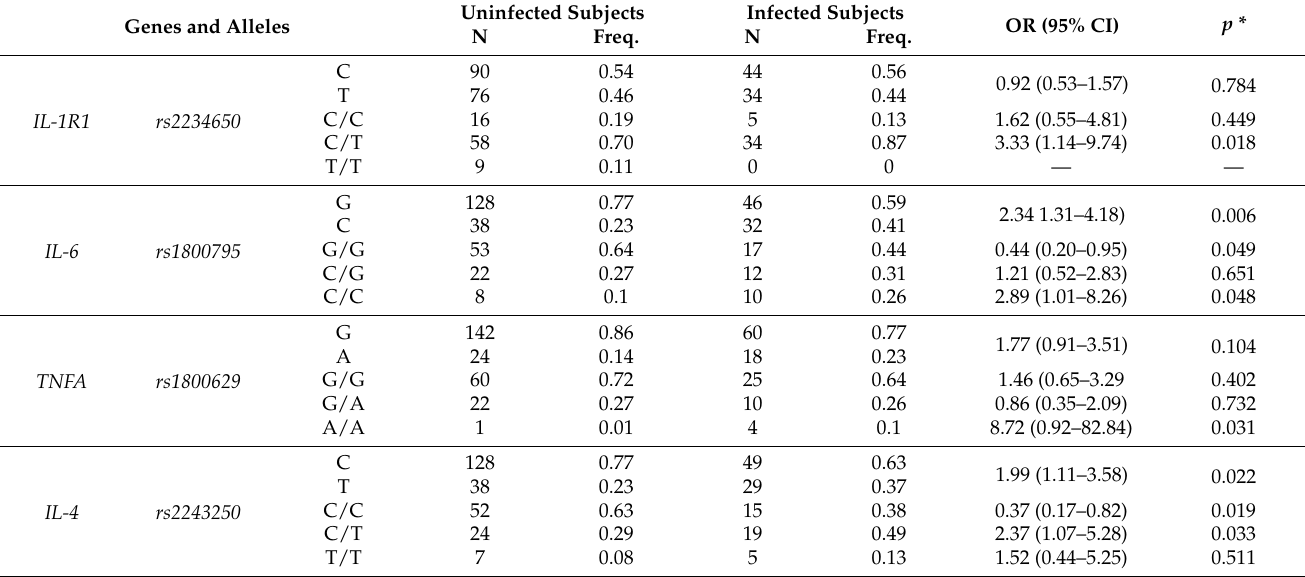
Table 8. Cytokine gene polymorphisms significantly associated with the detection of SARS-CoV-2 infection before day 105 post-administration of the second dose of recombinant mRNA